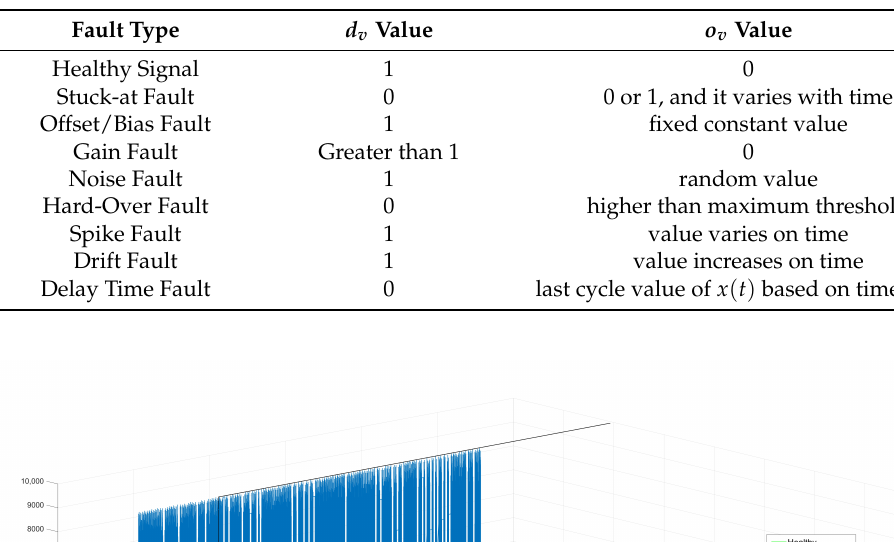
Table 1. Value of d v and o v for all fault types.